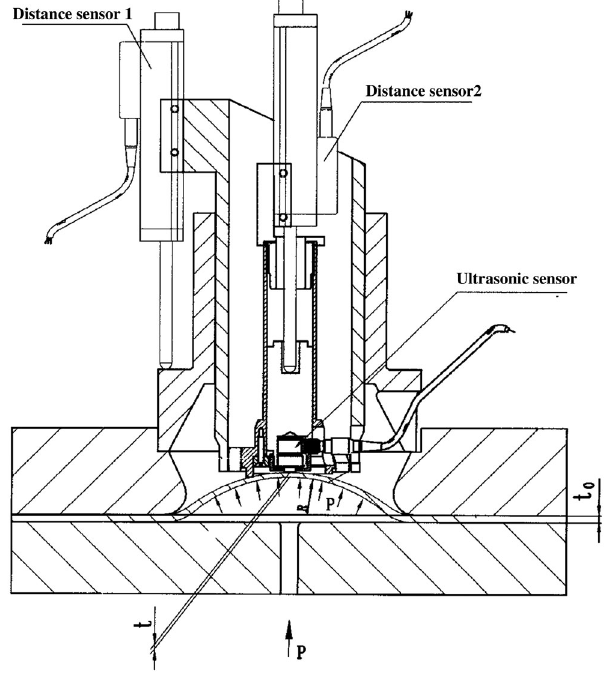
FIG. 3. Scheme of the bulge test